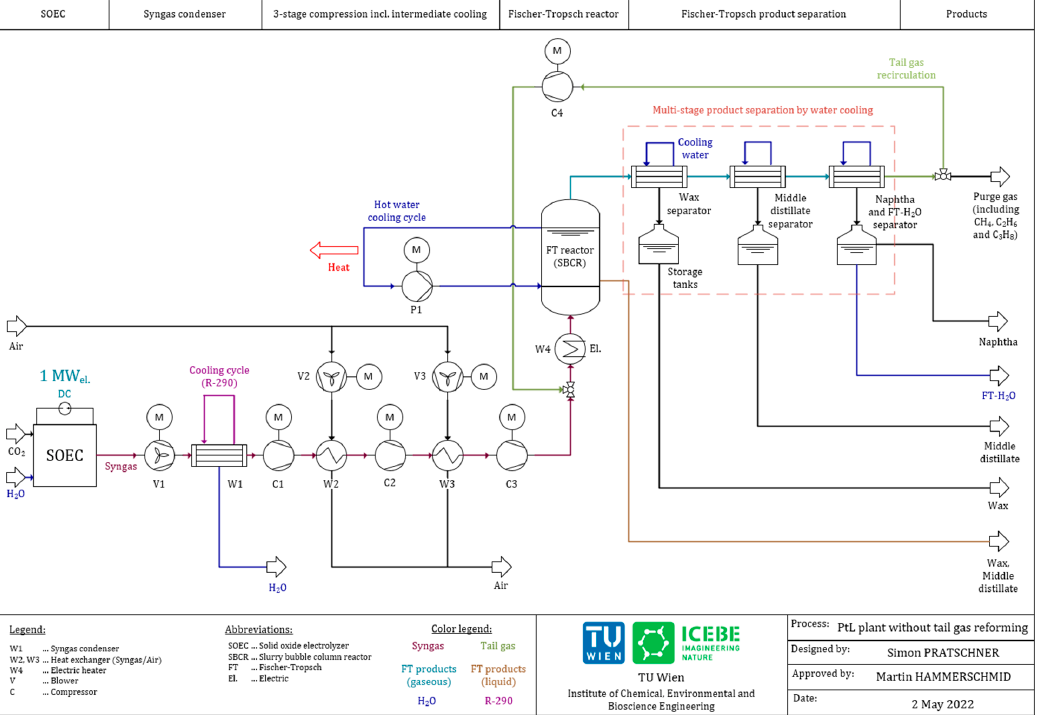
Figure 1. Scheme of the Power-to-Liquid plant without tail gas reforming.